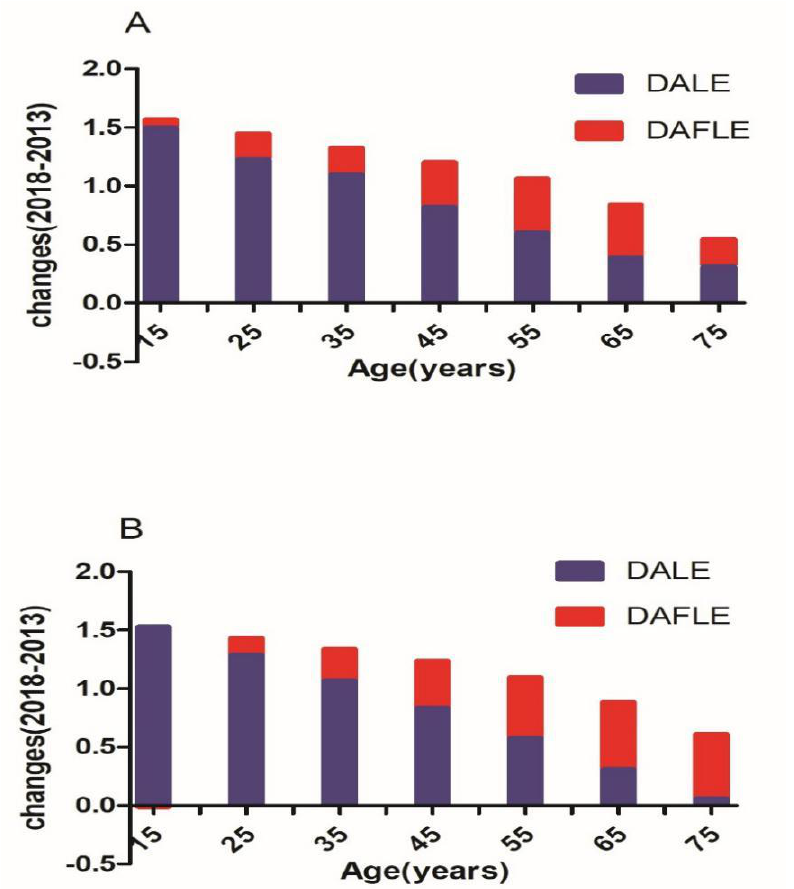
Figure 1. Absolute changes in depression and anxiety life expectancy (DALE) and depression and anxiety-free life expectancy (DAFLE) by sex at various ages in Jiangxi, China between 2013 and 2018 ( A ). men ( B ). women.